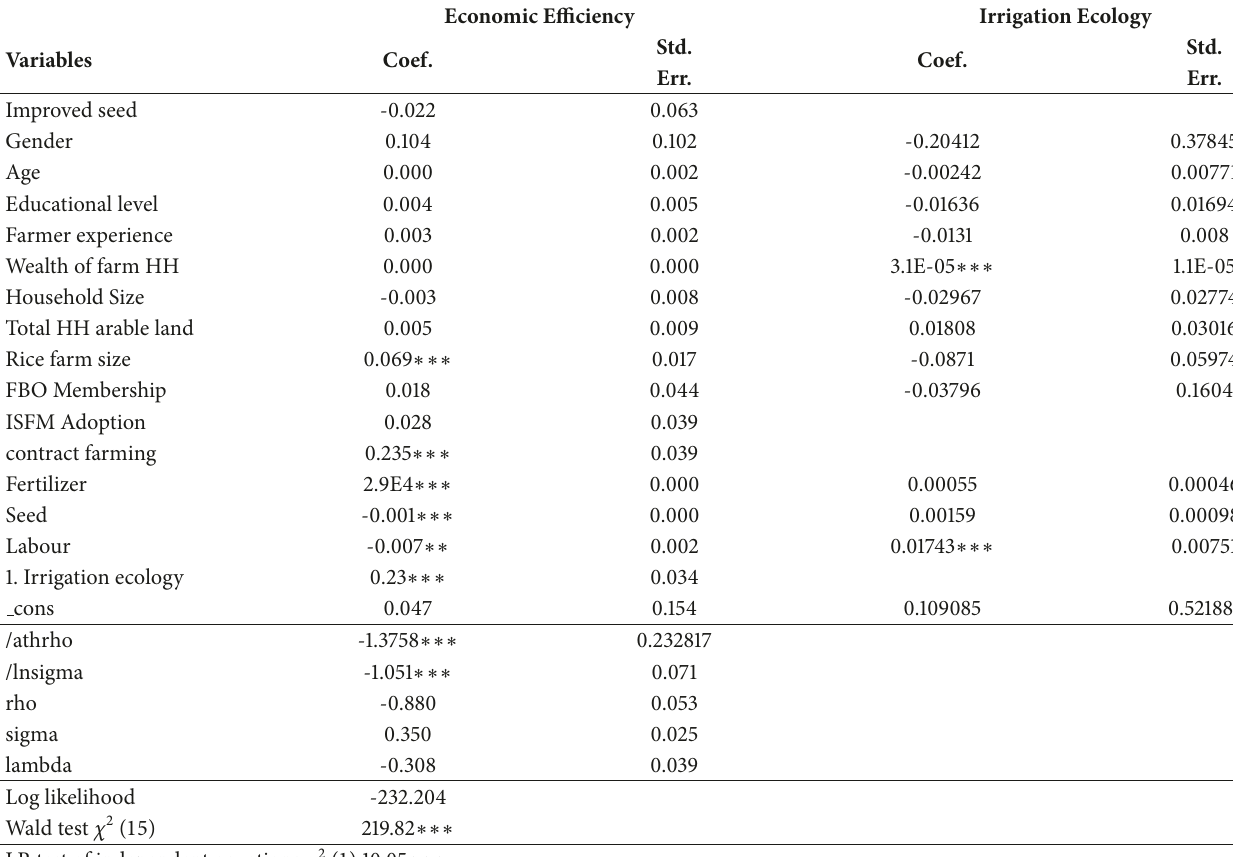
Table 9: Estimates of the endogenous treatment effect model of impact of irrigation ecology on economic efficiency.